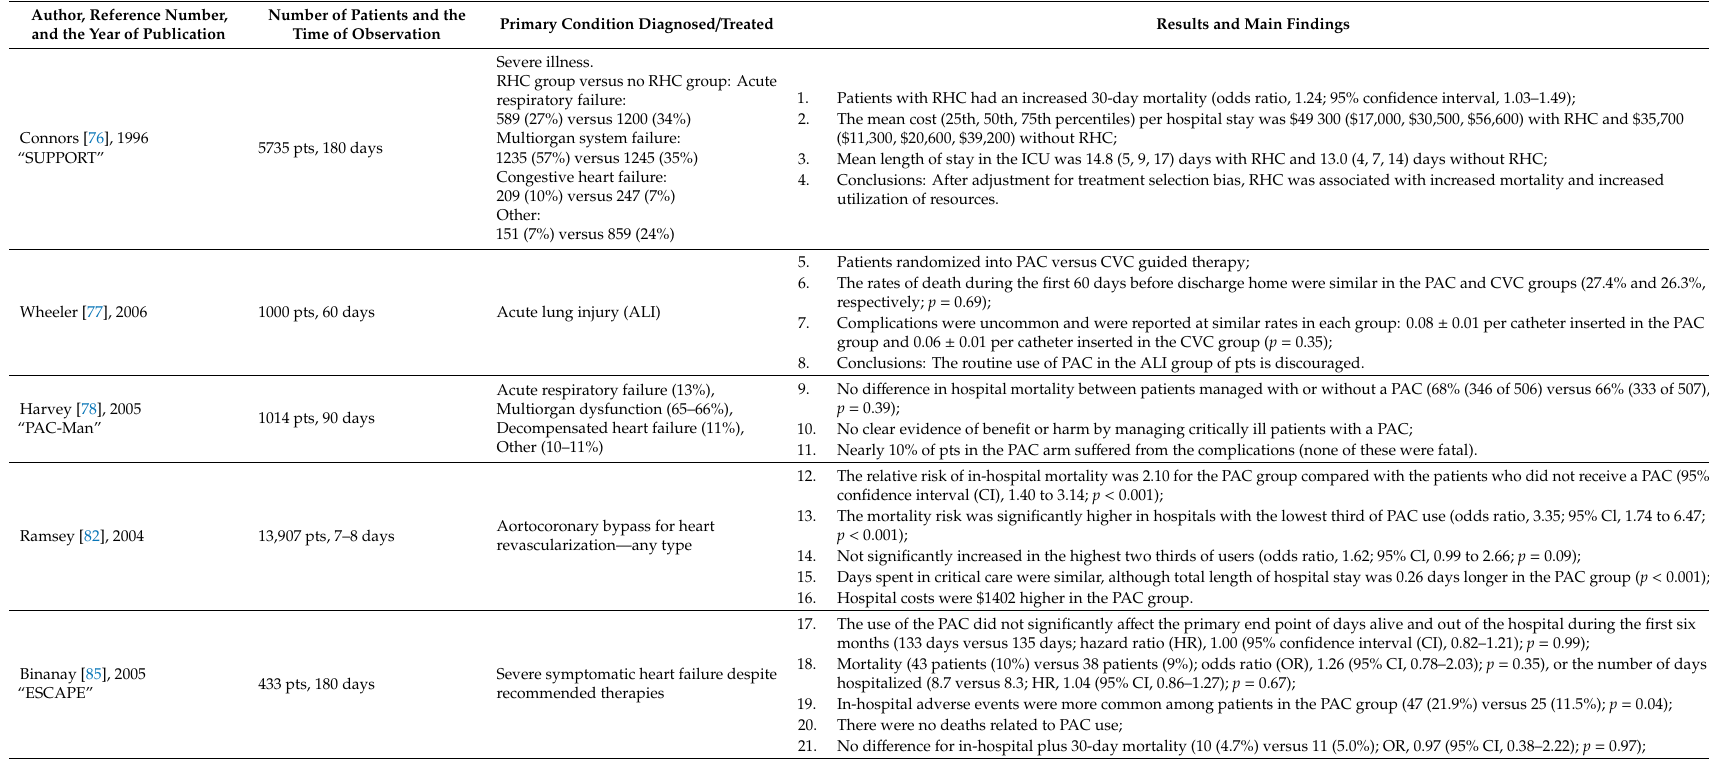
Table 2. Summary of the most important studies describing the role pulmonary artery